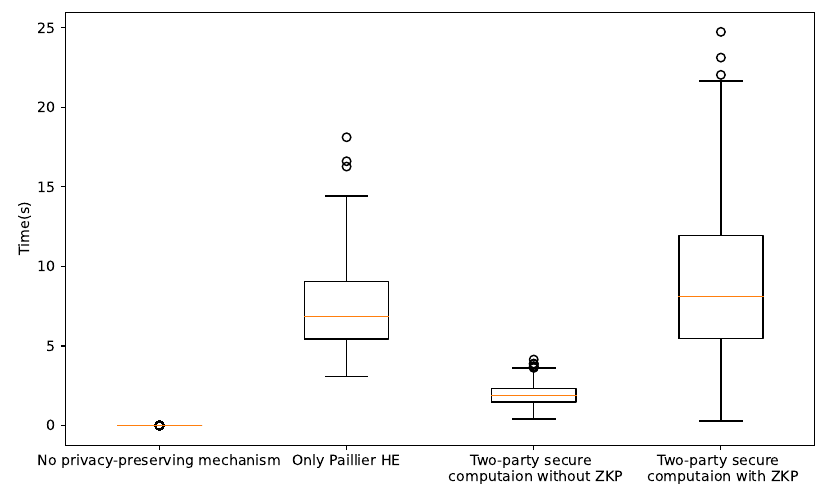
Figure 9. Computational time of different P2P negotiation mechanisms.